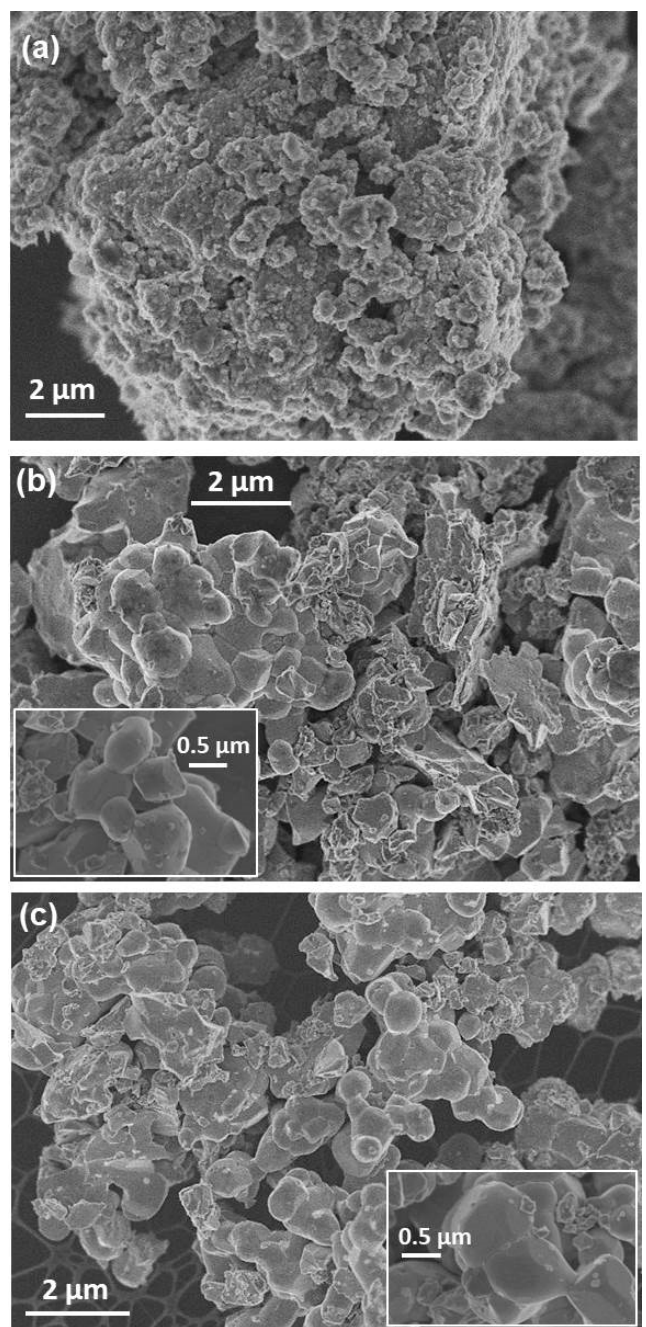
Figure 6. SEM micrographs of ( a ) PBMO-m , ( b ) PBMO-m + 1100 °C/Ar, and ( c ) PBMO-m + 1100°C/Ar + TG/air samples. The insets correspond to higher magnifications.